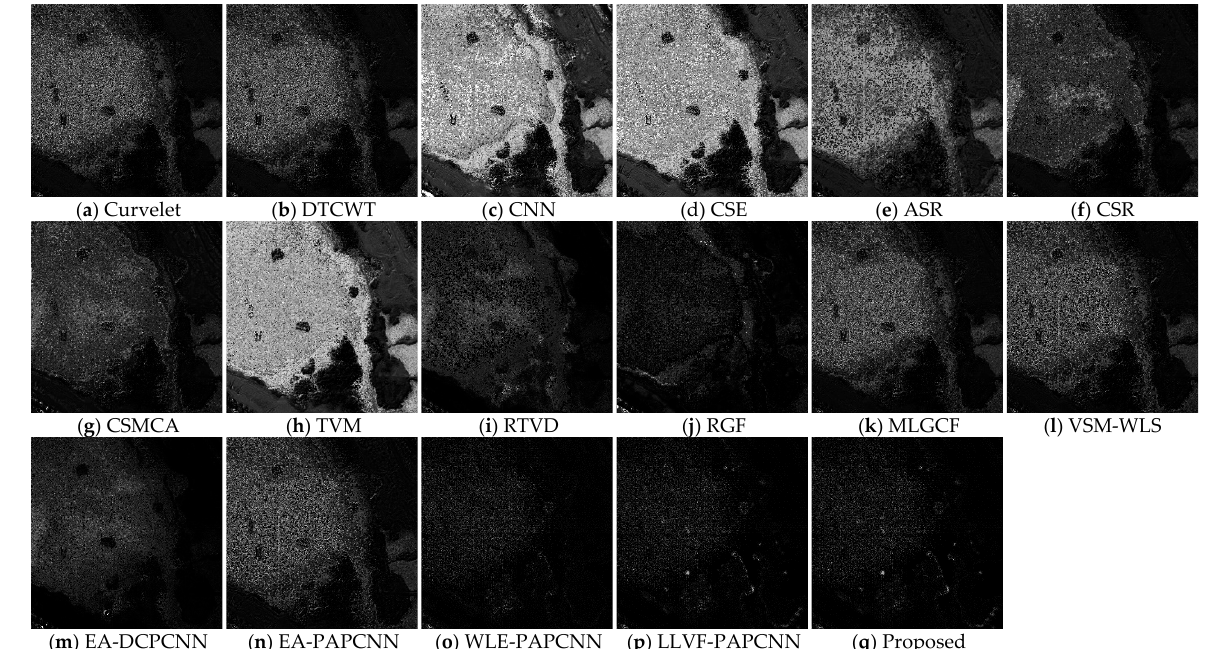
Figure 11. Fusion effect of WorldView-3 image.